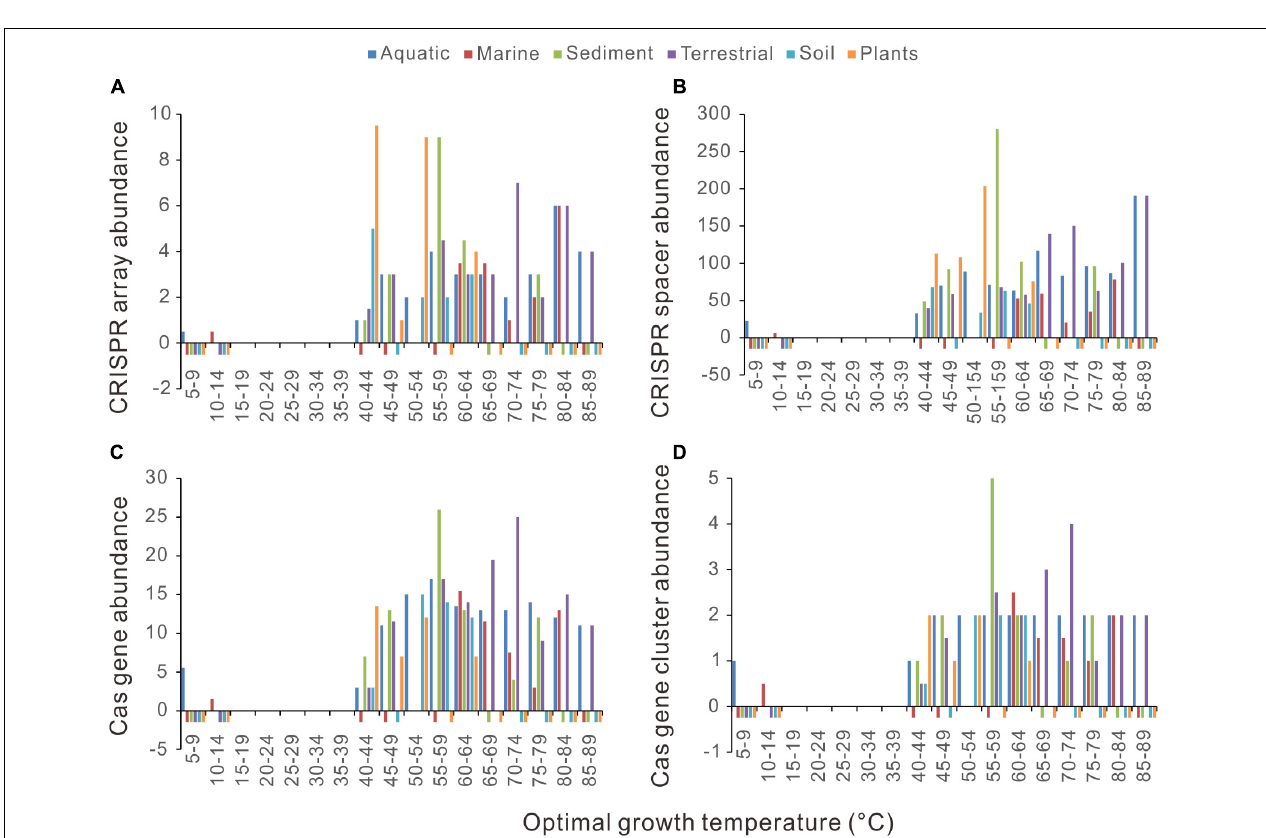
FIGURE 5 | Relationships between CRISPR-Cas abundances and optimal growth temperatures (Topt) in diverse environments. (A) CRISPR arrays. (B) CRISPR spacers. (C) cas genes. (D) cas gene clusters. Because median values are less sensitive to extreme outliers than the mean values, we created the column charts using the median value of each Topt range. The Topt ranges without any samples were marked out using short negative bars.